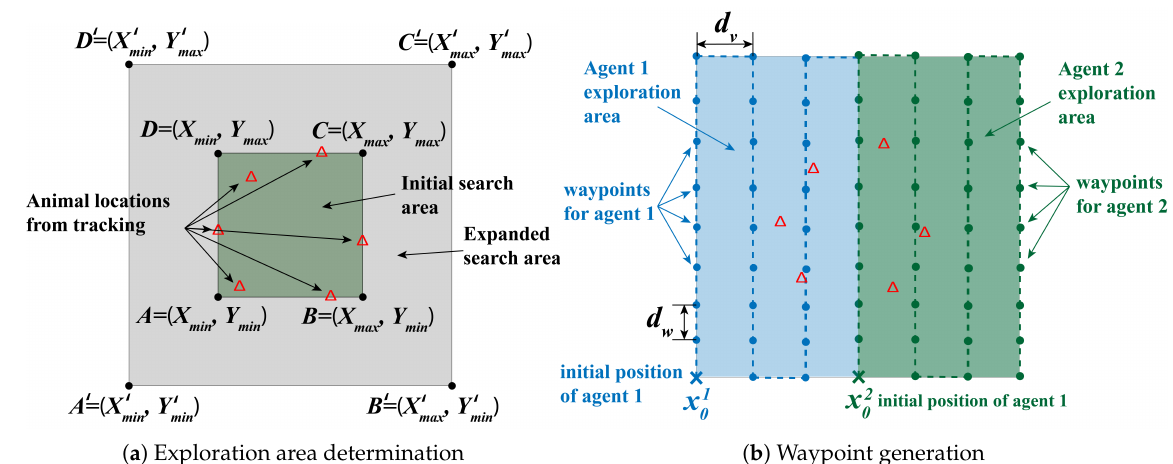
Figure 5. Schematic for the Lawn Mower exploration strategy with two